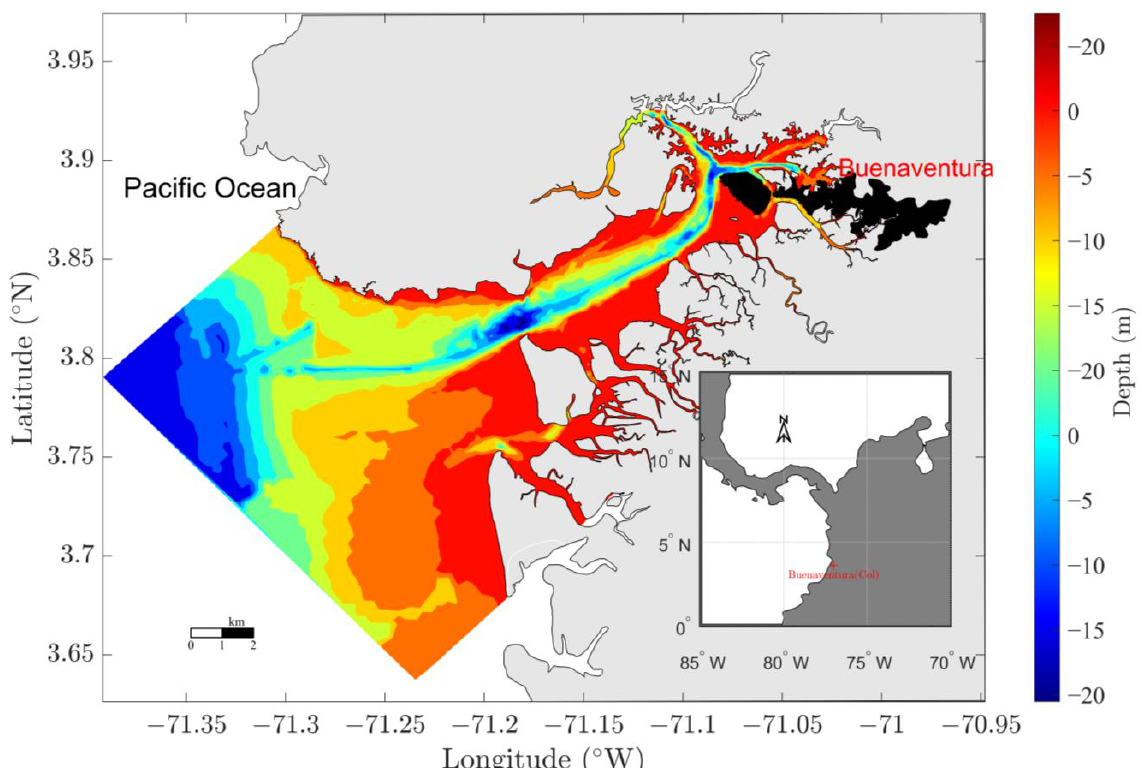
Figure 5. Simulation domain bathymetry built-up area with black. The open boundaries at the southeast, southwest, and northwest of the outer bay were forced with the current, water level, salinity, and temperature data from the HY- COM global model [43]. Wind direction and speed, solar radiation, humidity, and air tem- perature data were taken from a meteorological station and considered uniform over the simulation domain. The simulation model was run for one year (2021) to determine the effect of wastewater discharges on Buenaventura Bay. Freshwater from the Dagua (66.10 m 3 /s), Achicayá (98.90 m 3 /s), Humane (30 m 3 /s), Gamboa (30 m 3 /s), Aguacate (10 m 3 /s), San Antonio (20 m 3 /s), Hondo (10 m 3 /s), and Agua Dulce (80 m 3 /s) rivers and estuaries was considered in the model. The mean flows and temperatures of each river and estuary were accounted for. Average FC concentrations of 28,960 and 4724 MPN/100 mL were included in the Dagua and Achicayá rivers, respectively, as reported by Vivas et al. [9]. 2.5. Calibration and Validation of Models The models were calibrated by comparing the simulation results with measurements of currents, tides, and fecal coliform (FC) concentrations (MPN/100 mL). The calibration period was from February to March, while the validation period was from October to November and was chosen to capture seasonal variations in rainfall. The region experi- ences a high rainfall of over 6500 mm/year and has two seasons with distinguishable rainy periods: a low rainy season from January to June and a high rainy season from July to December [44]. The monitoring station that is used for current and tidal measurements is indicated as T1 in Figure 1. AANDERAA RCM9 LW (0 to 300 cm/s) equipment was de- ployed at a depth of 6 m for current measurements, while tidal measurements were made with AANDERAA WLR7 equipment (0 – 700 kPa), and both devices were programmed to collect data every 15 min.